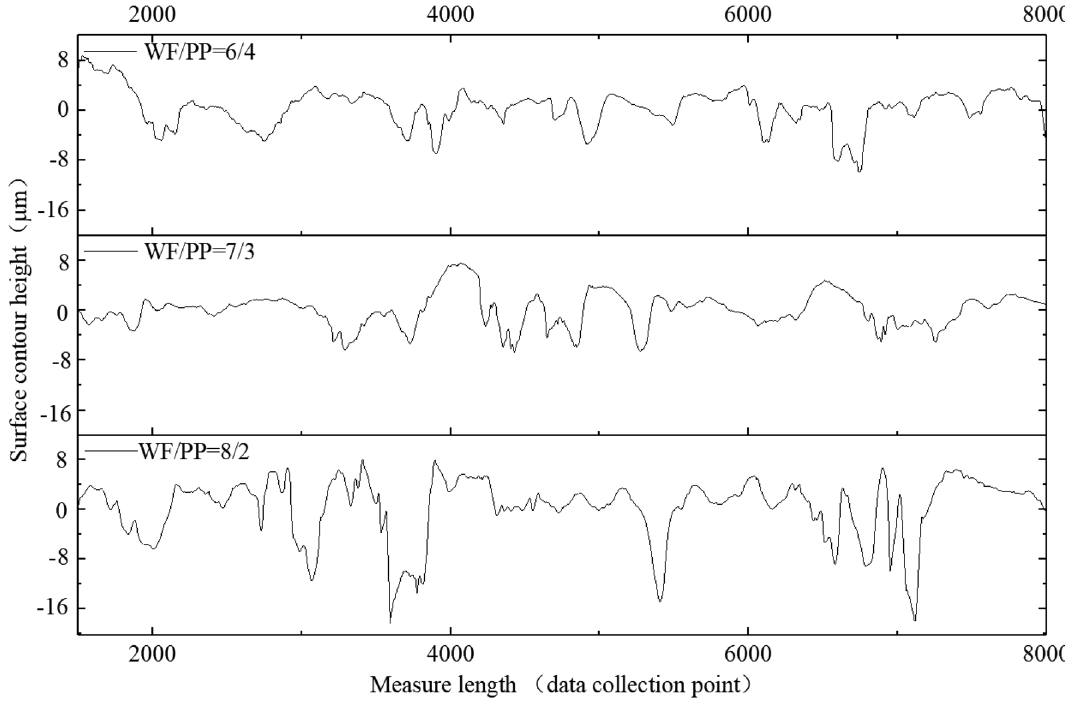
Figure 8. Surface contour of WF/PP composite.